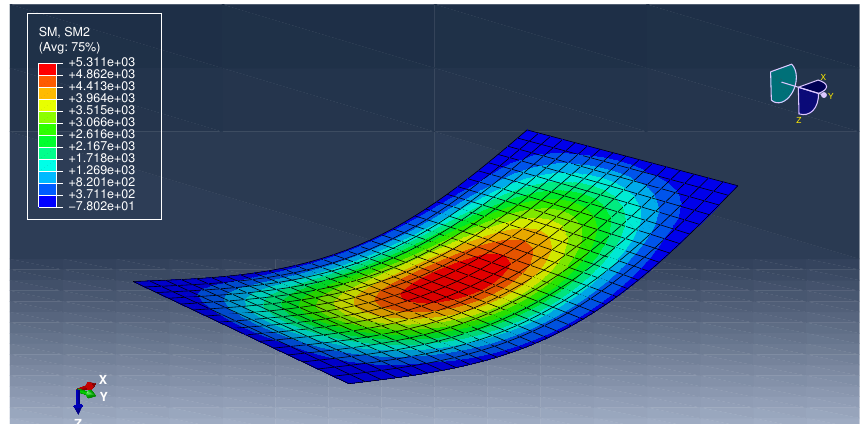
Figure A3. The bending moment M 22 of a rectangular plate with two opposite edges simply supported and the other free solved using FEM.